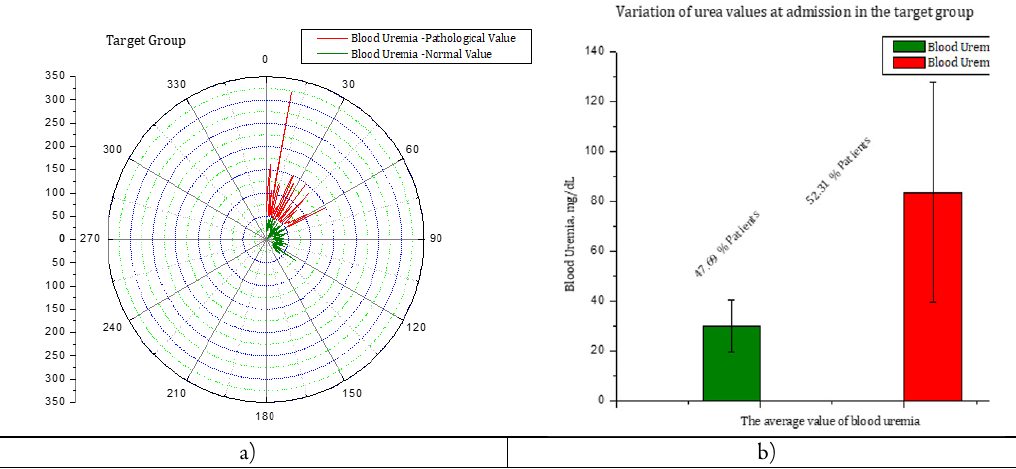
Figure 1. Variation of urea values at admission in the target group Legend: a) Uremia value is represented for all patients in the target group; b) The average value of uremia for patients with normal values of blood uremia (<45 mg/dl) and the average value of uremia for patients with pathological values of blood uremia (>45 mg/dl) were